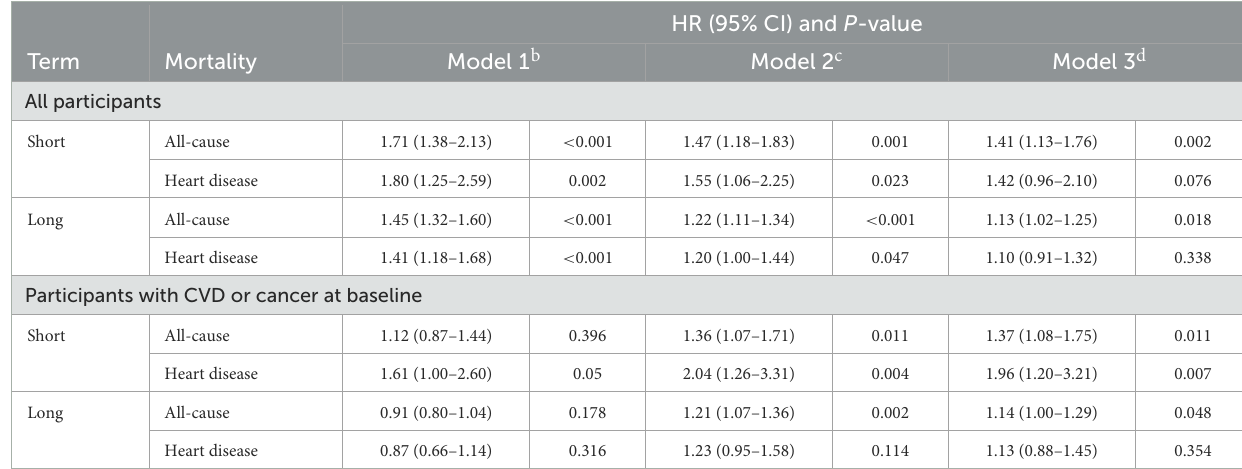
TABLE 4 Associations of sleep complaints with short- or long-term all-cause and heart disease mortality among all participants and subgroups with CVD or cancer a